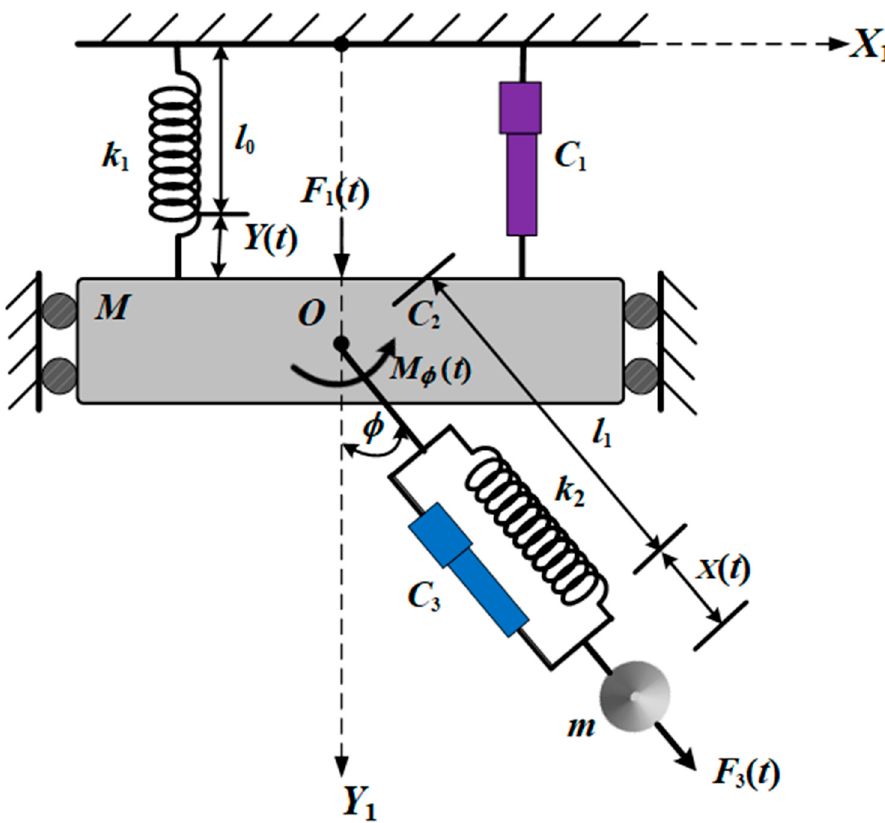
Figure 1. Description of the system.